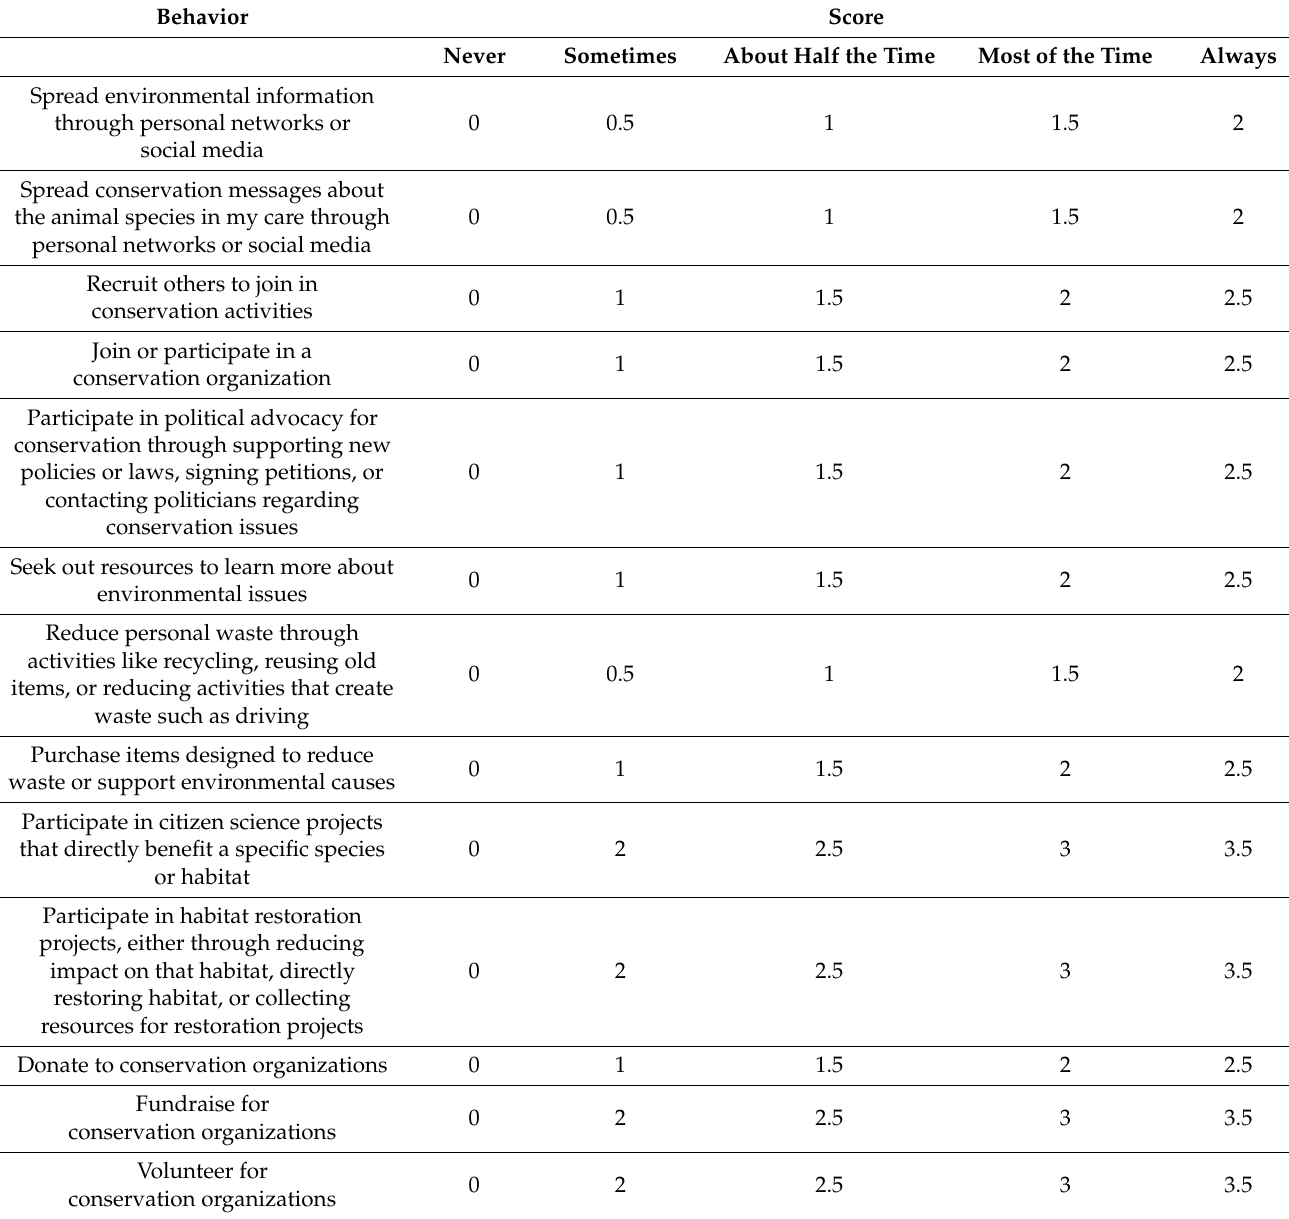
Table 1. Point value assignments for reported conservation